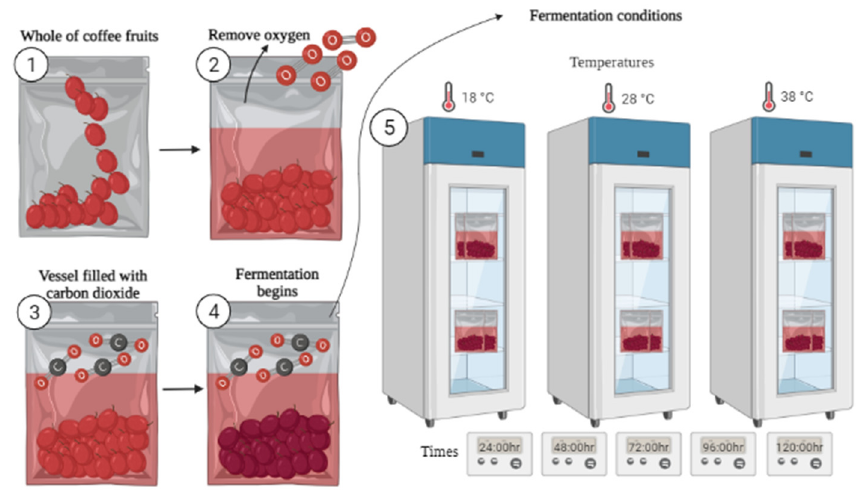
Figure 1. Carbonic maceration process